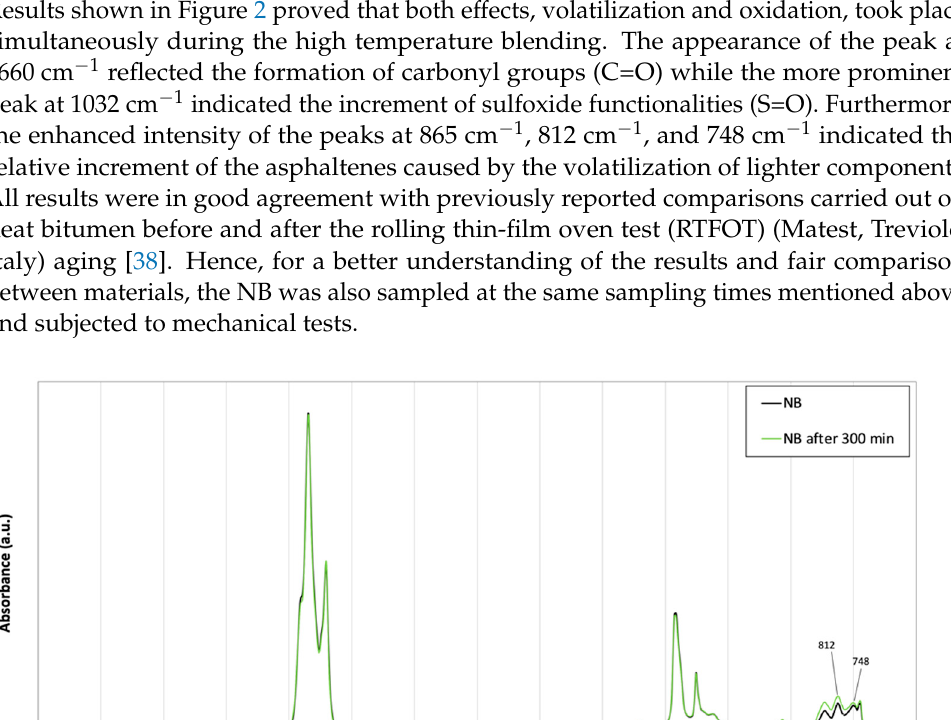
curve.’ In this graphical representation, datapoints at low-frequency were associated with